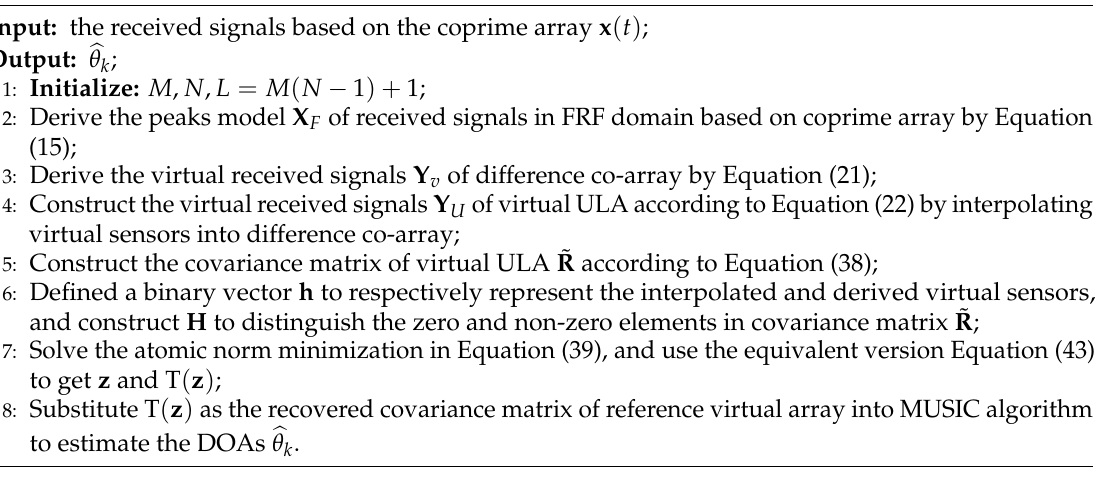
Algorithm 1 Underdetermined DOA Estimation of Wideband LFM Signals Based on Gridless Sparse Reconstruction in FRF